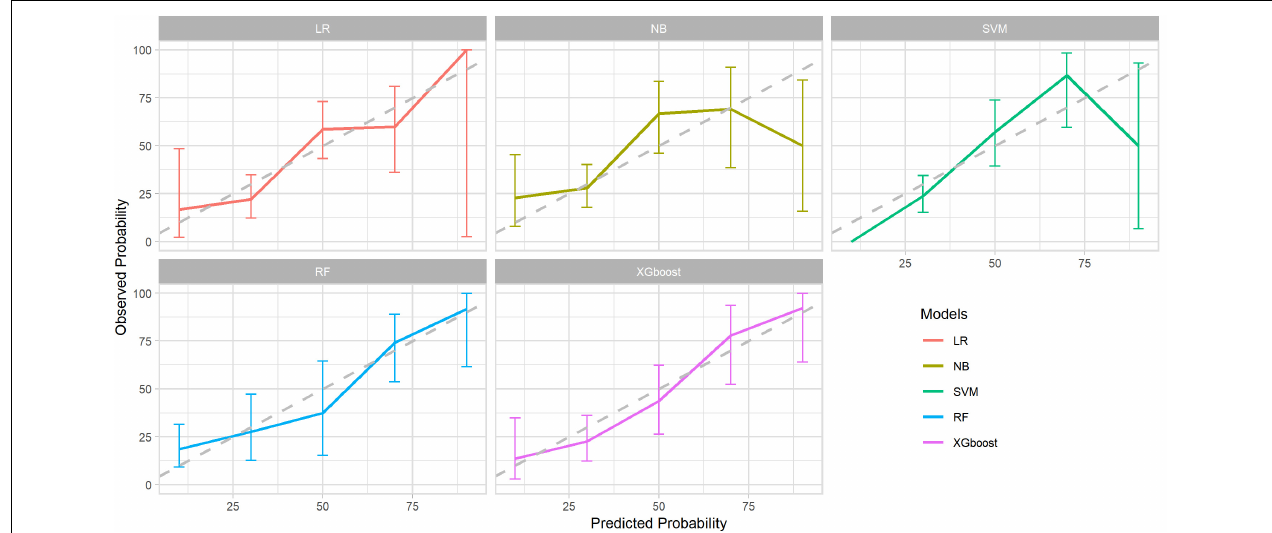
FIGURE 6 | Calibration curve of the four machine learning models and LR